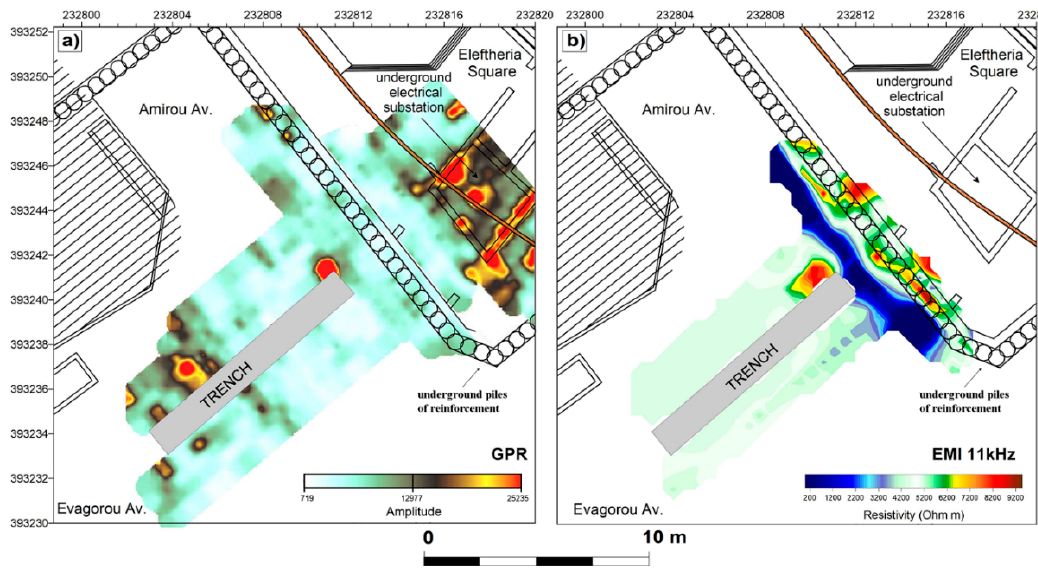
Figure 14. GPR slice relative to the time window 14–18 ns ( a ), EMI resistivity map relative to the frequency of 11 kHz ( b ).